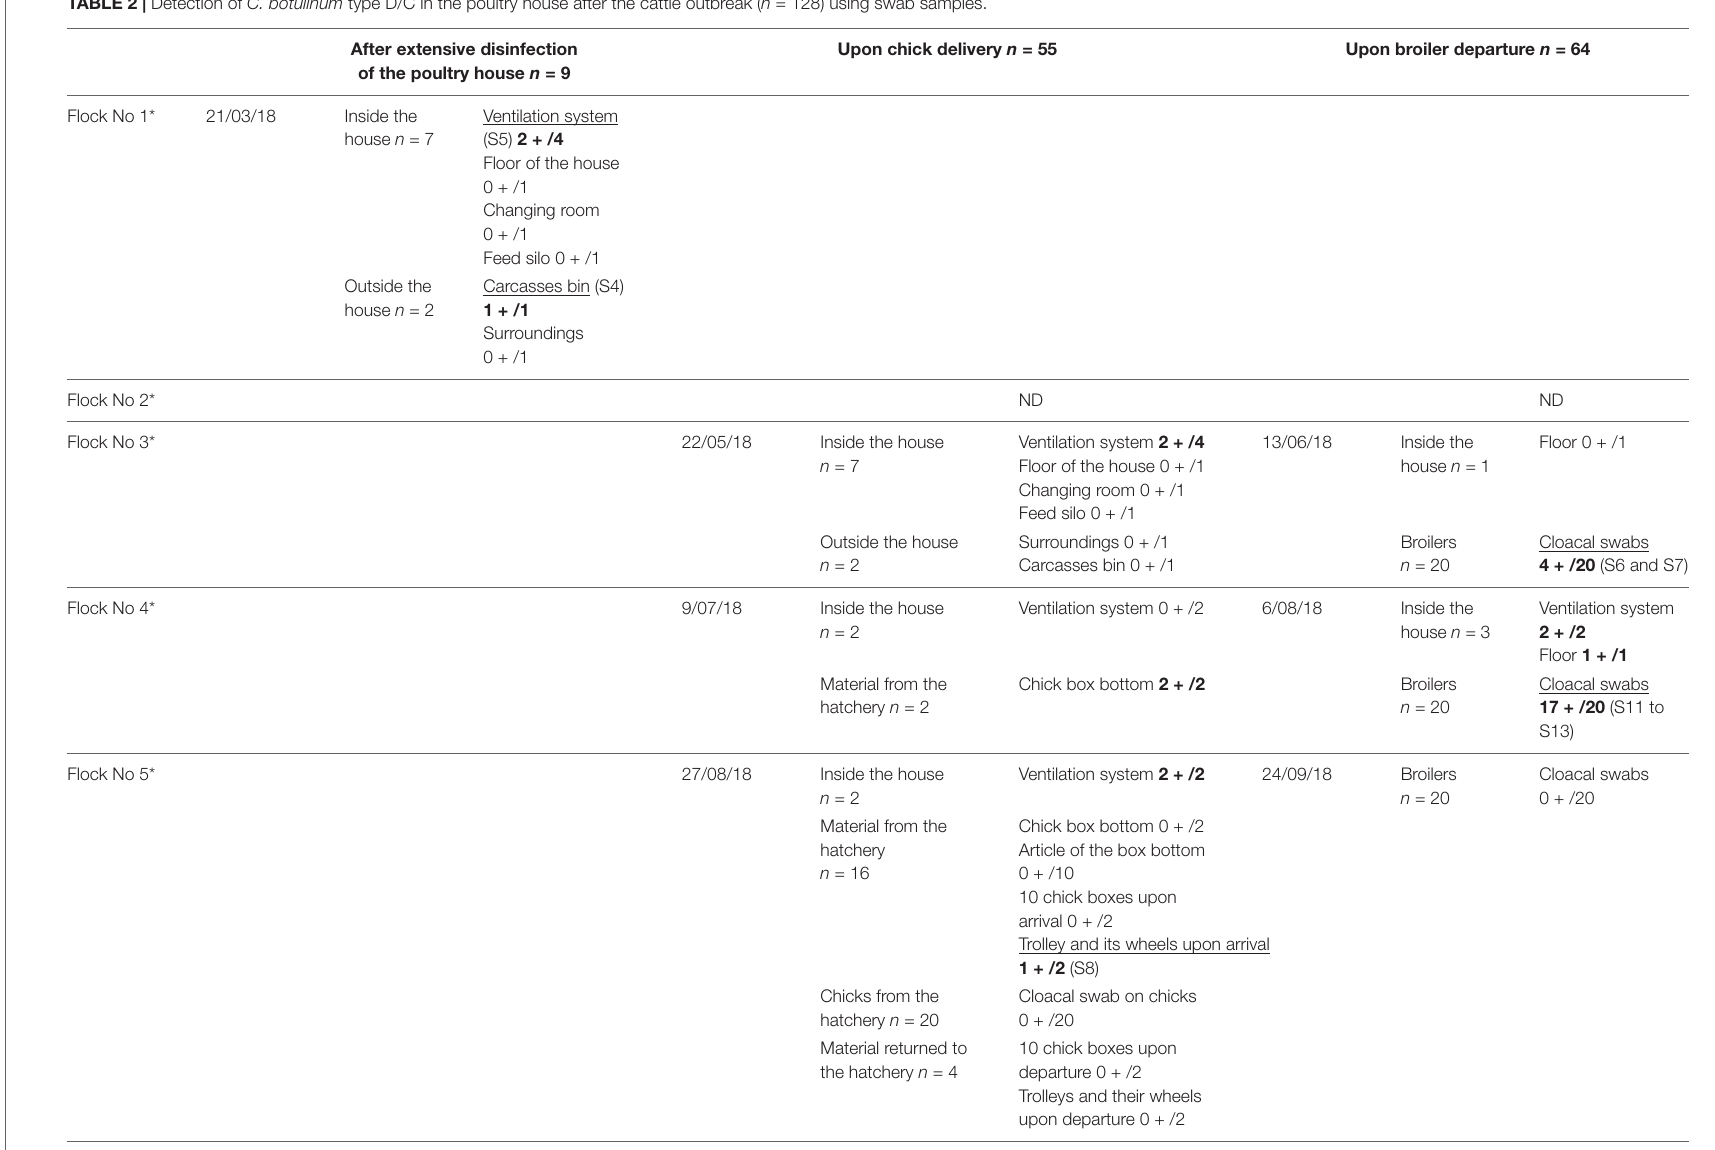
ND, no data. *Number of positive samples/number of samples collected (positive samples are in bold). Samples tested by MLVA are underlined and the sample code in Figure 2 is indicated in